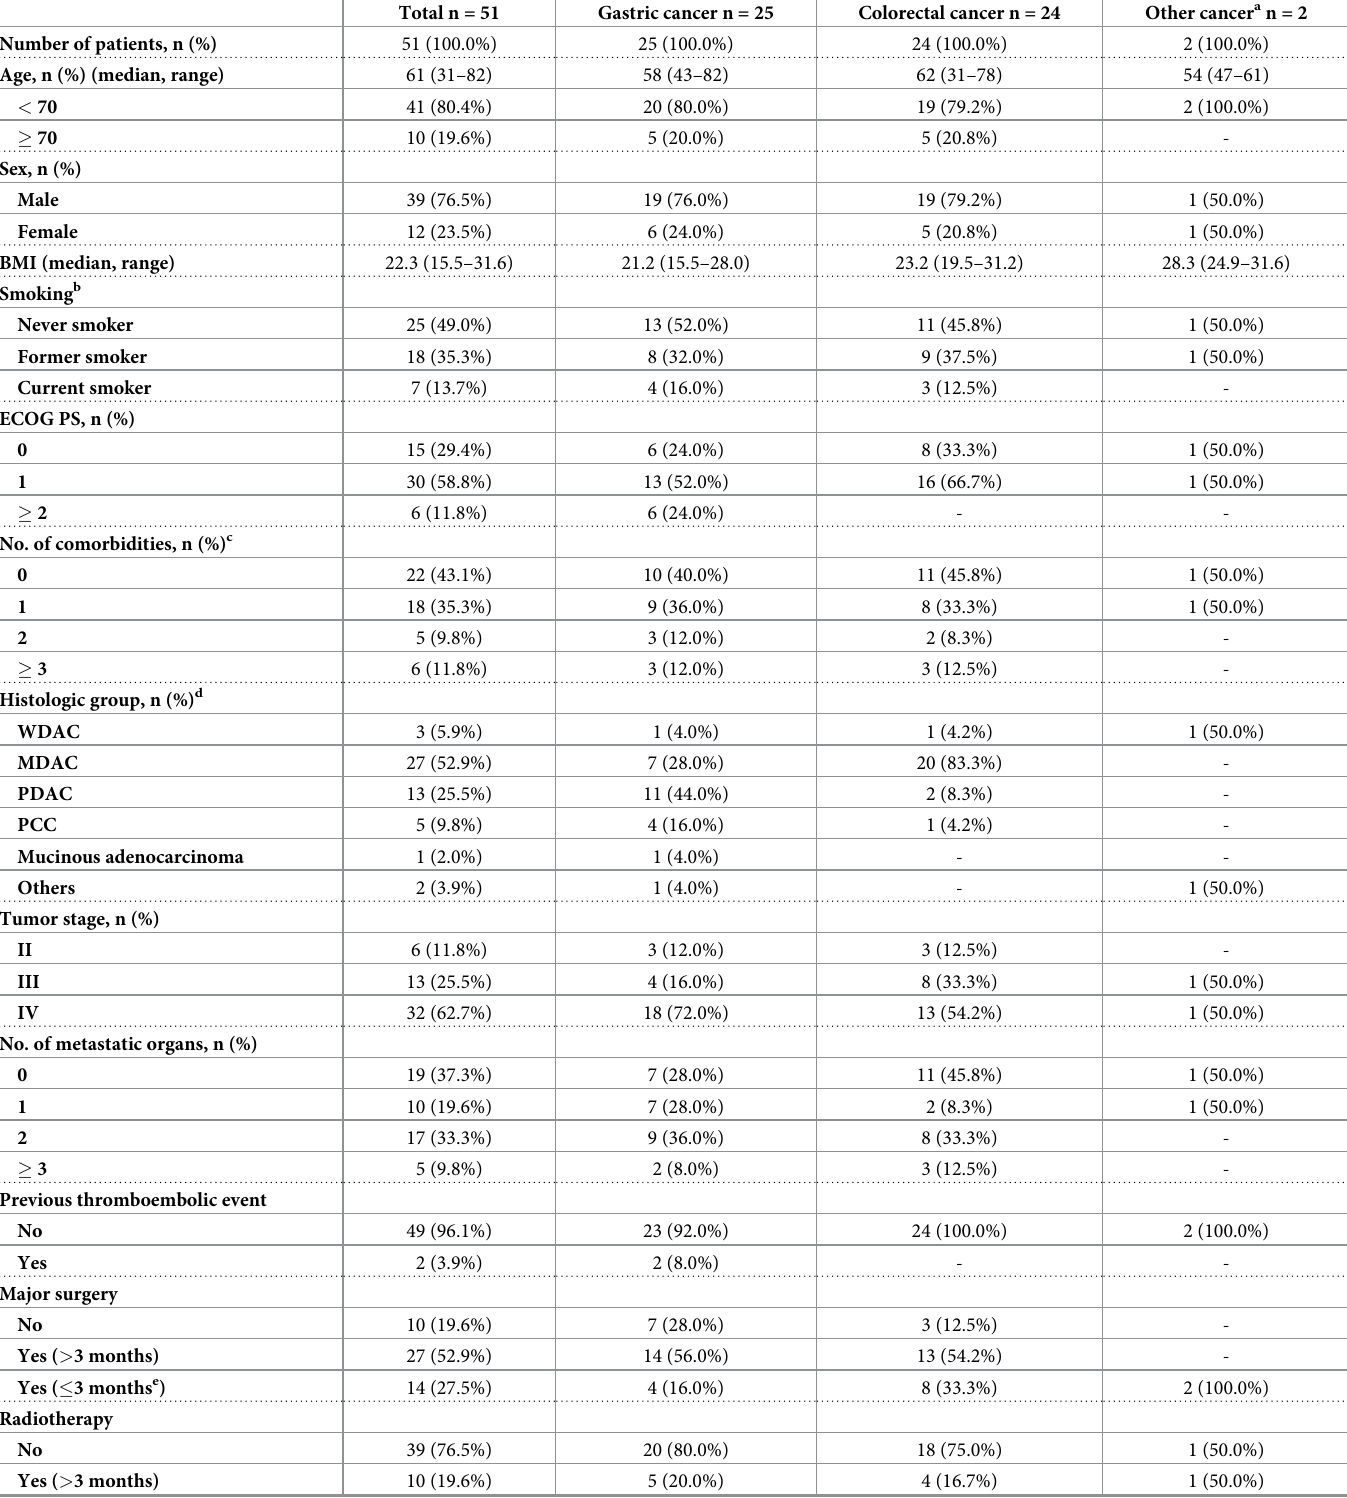
Table 1. Patient